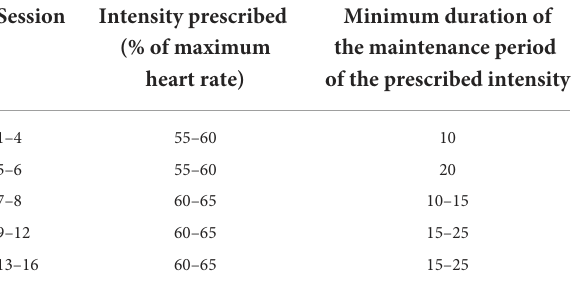
TABLE 1 Intensity and duration of aerobic exercise session by